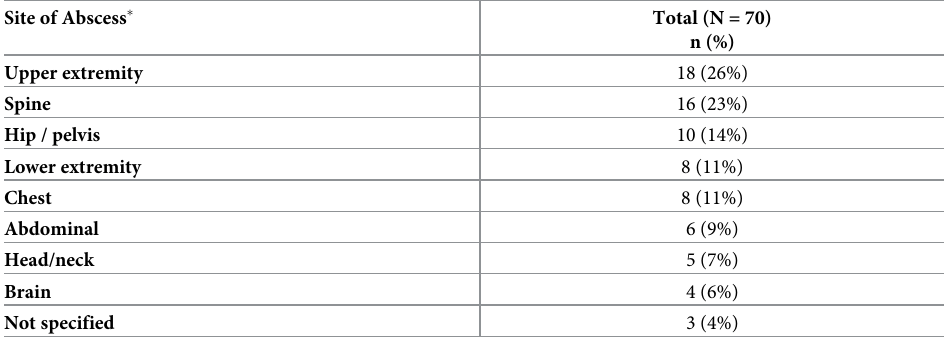
Table 3. Site of abscesses. Site of Abscess �